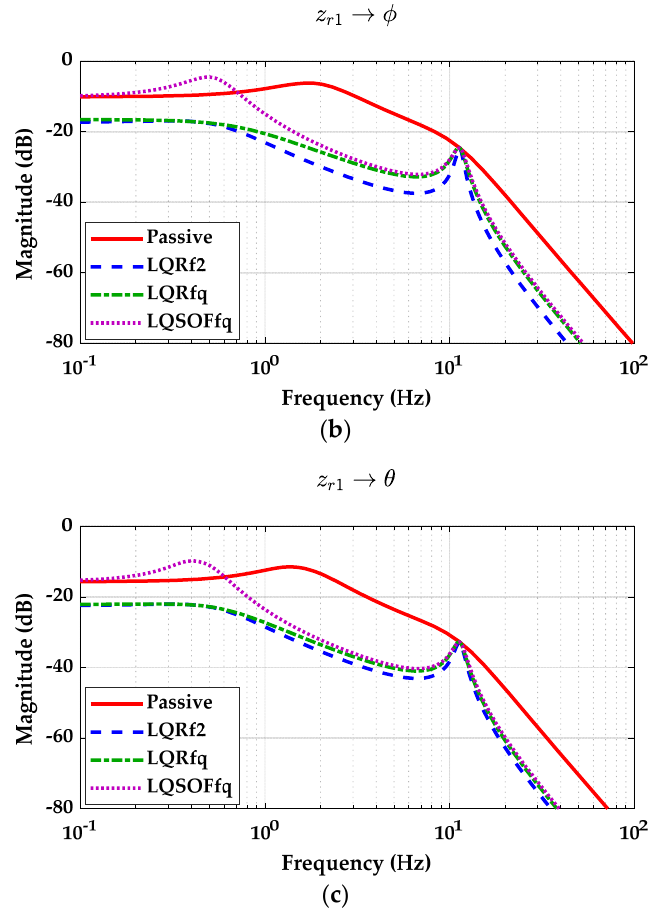
Figure 6. Frequency responses from the road profile z r 1 to each output for static output feedback case. ( a ) Vertical acceleration of the sprung mass; ( b ) Roll angle of the sprung mass; ( c ) Pitch angle of the sprung mass. Table 6. Gain matrices of LQSOF and LQSOFq. K SOF